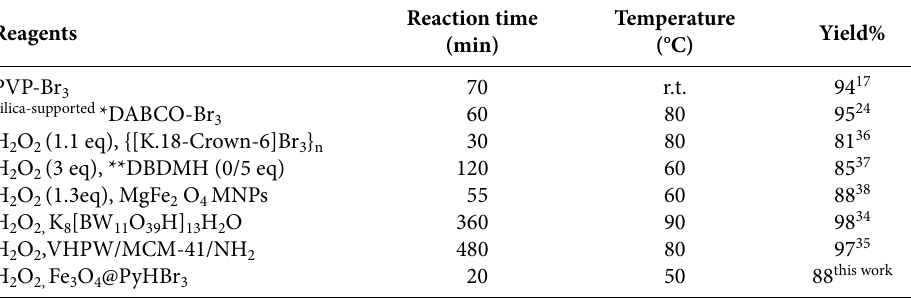
Table 4. Comparison of the present method with other methods reported for the oxidation of benzyl